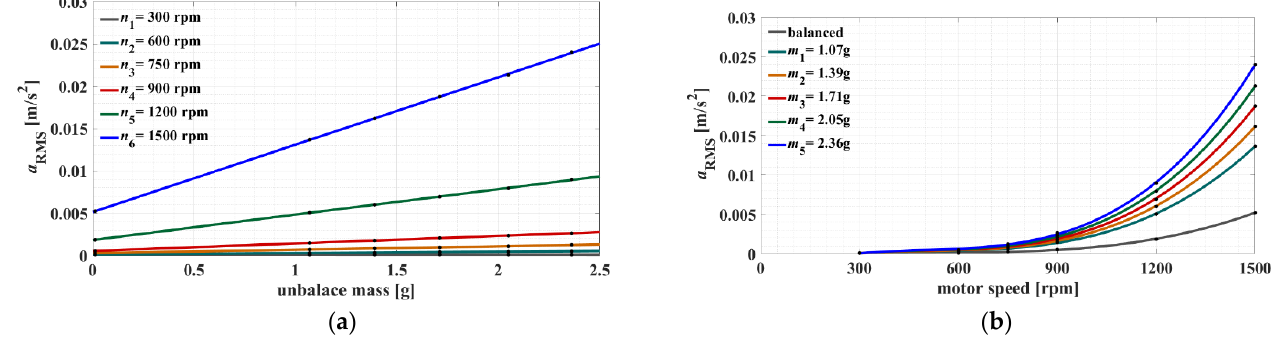
Figure 8. Symptom 1 f r of mechanical vibration acceleration in the radial direction as a function of changes in unbalance mass, m n , ( a ) and rotational speed, n ( b ).